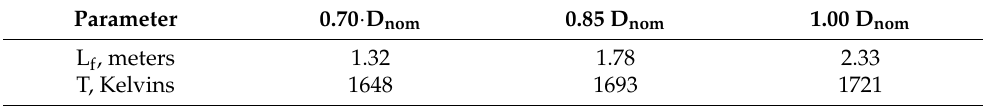
Table 1. The results of the measurements.